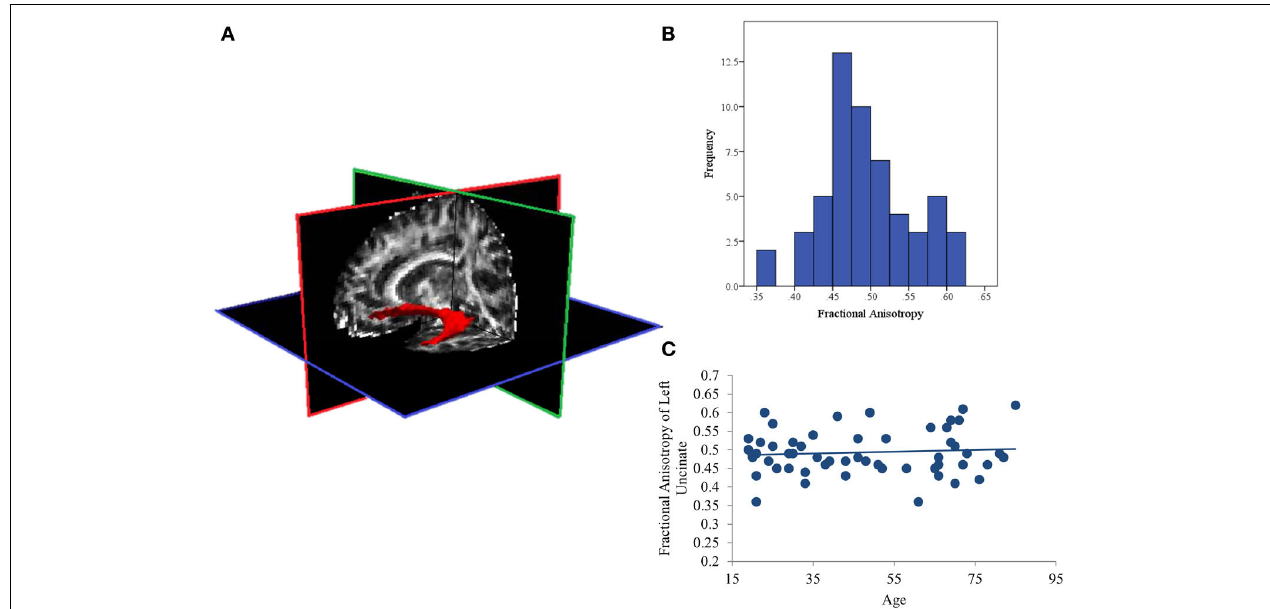
FIGURE 1 | (A) Representative posterior distribution of the reconstructed uncinate fasciculus thresholded at 20% maximum; (B) Histogram of average Fractional Anisotropy (FA) values for the uncinate fasciculus in all subjects; (C) Scatterplot showing that aging is not associated with FA values in this sample.